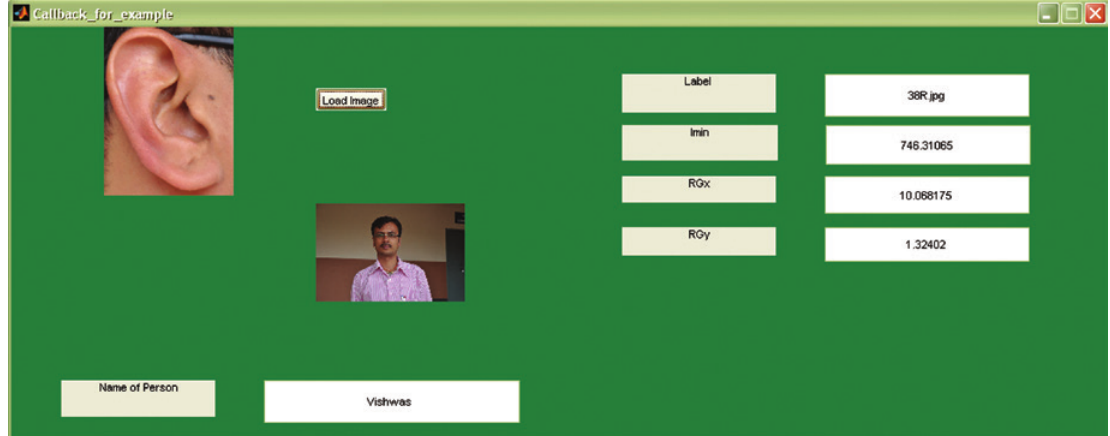
Figure 11: Typical Snapshot of the Identification System of Three Features.